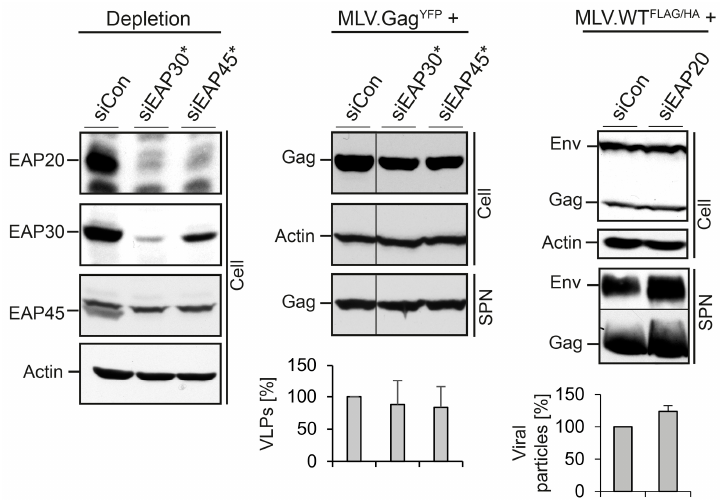
Figure 3. Impact of ESCRT-II on MLV VLP and virion release. Control siRNA or single siRNAs against EAP30 or EAP45 were introduced into HuH-7 cells prior to transfection with MLV.Gag. To assess depletion and co-depletion effects of the siRNAs, lysates were reacted with antibodies recognizing EAP20, EAP30, and EAP45. ß-Actin-specific WB was used to control equal gel loading ( left panel). Cell-associated Gag and extracellular VLPs (SPN) were probed with anti-GFP WB ( middle panel). VLPs values were determined by densitometry and demonstrated in percent amount relative to control cells ( n = 2 ). Cells were treated with control siRNA or an EAP20-specific siRNA pool prior to transfection with MLV.WT FLAG/HA . Cell lysates and supernatants (SPN) were analyzed by FLAG/HA-specific WB and densitometric analyses ( n = 2 ) ( right panel) exactly as outlined in Figure